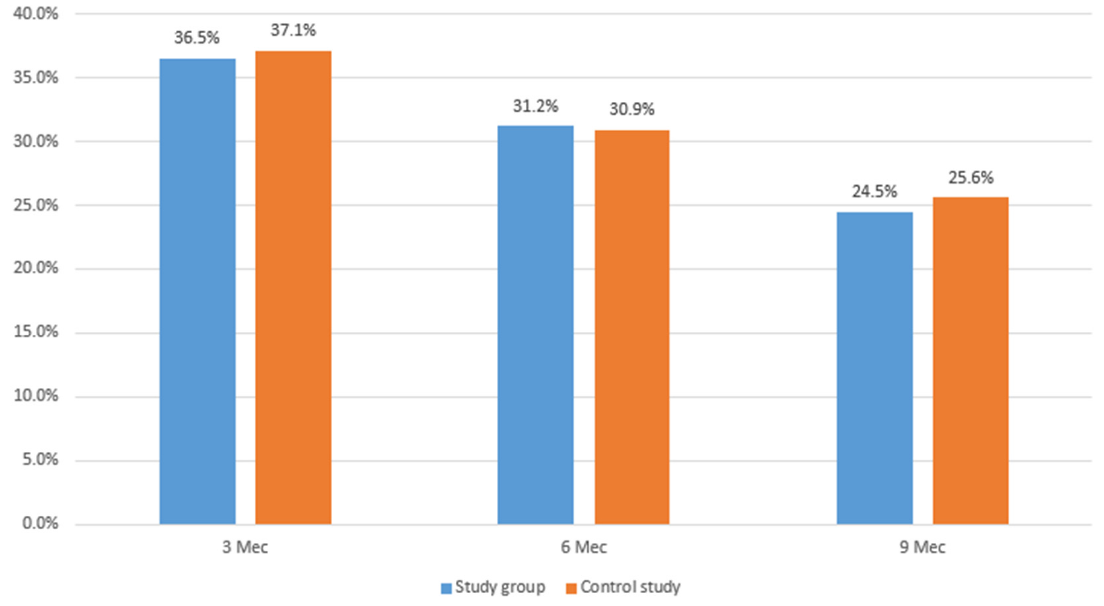
Figure 5. Assessment according to the Oswestry questionnaire (average ODI by group), %.